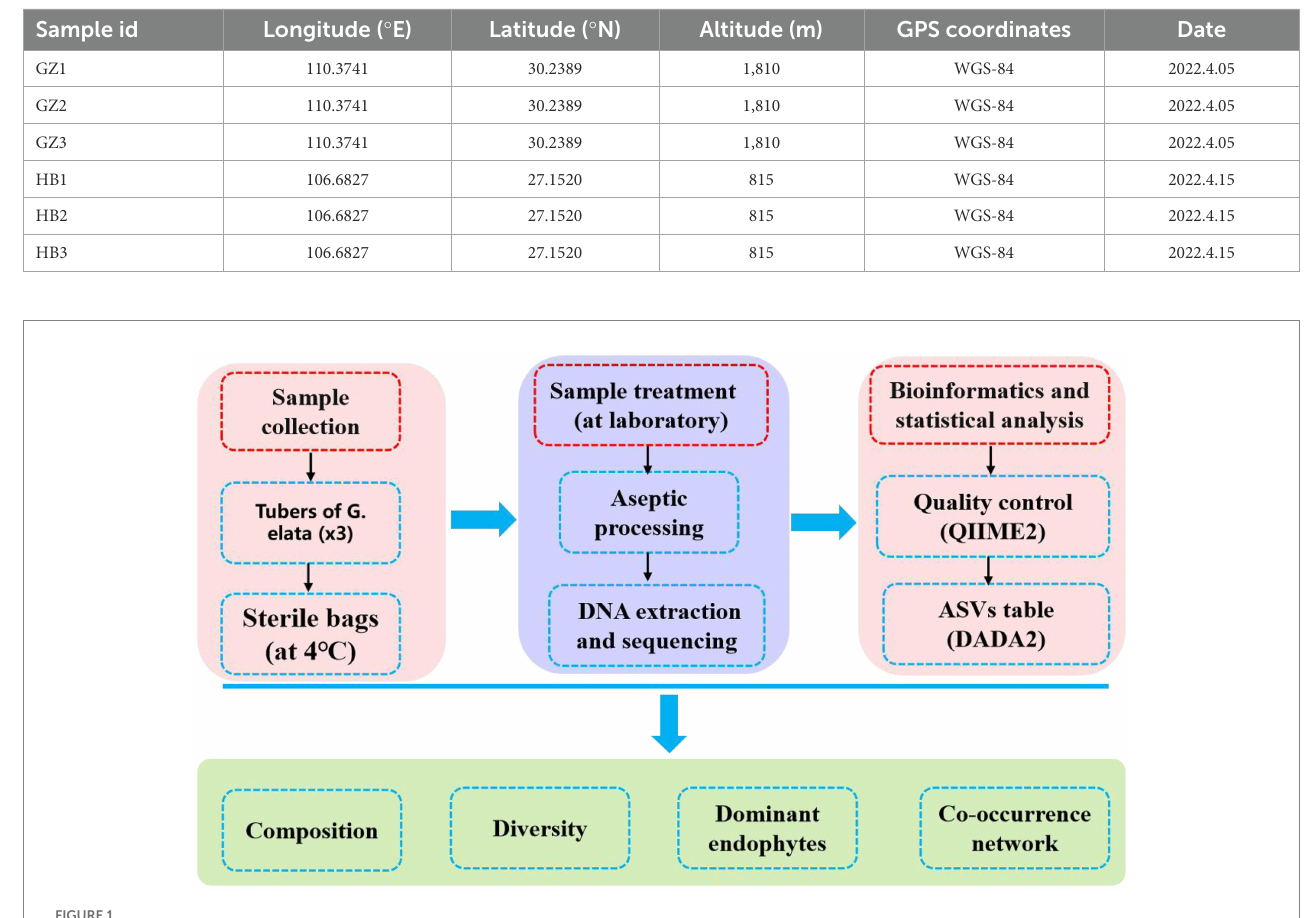
FIGURE 1 Study basic framework diagram.